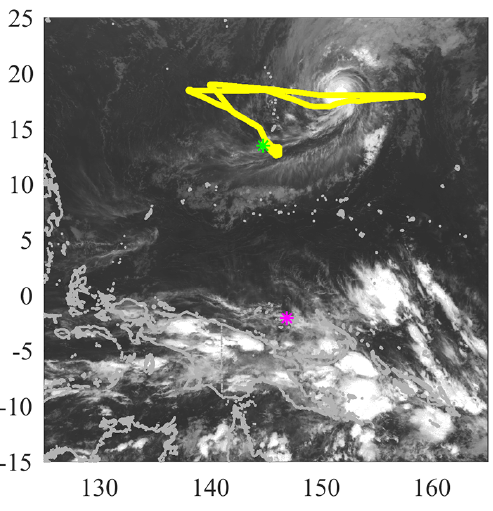
Figure 5. Satellite image of 4 March at 12:00UTC, coincident with flight RF03. Cyclone Faxai is visible to the northeast of Guam.